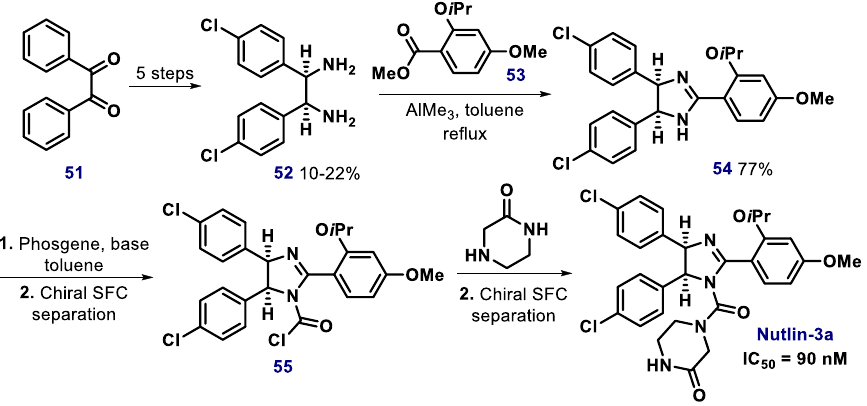
Figure 4. Crystal structure of the complex of Nutlin-3 with p53-MDM2 (Murine Double Minute 2) available on PDB under code 5C5A (in the chemical structure, carbon atoms are drawn in pink, nitrogen in blue, oxygen in red and chlorine in